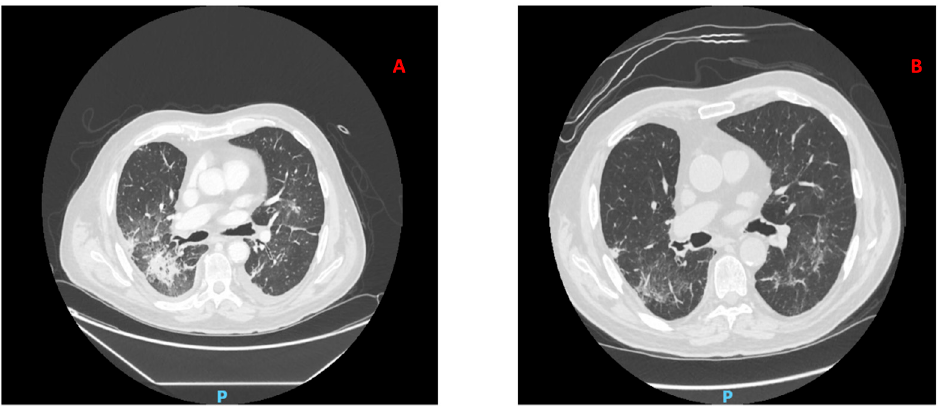
Figure 1. Radiological images ( A ) CT scan pre-therapy; ( B ) CT scan 21 days after therapy with L-AmB. After two weeks from the onset, the cultures were identified as the mold, Geosmithia argillacea (Figure 2).